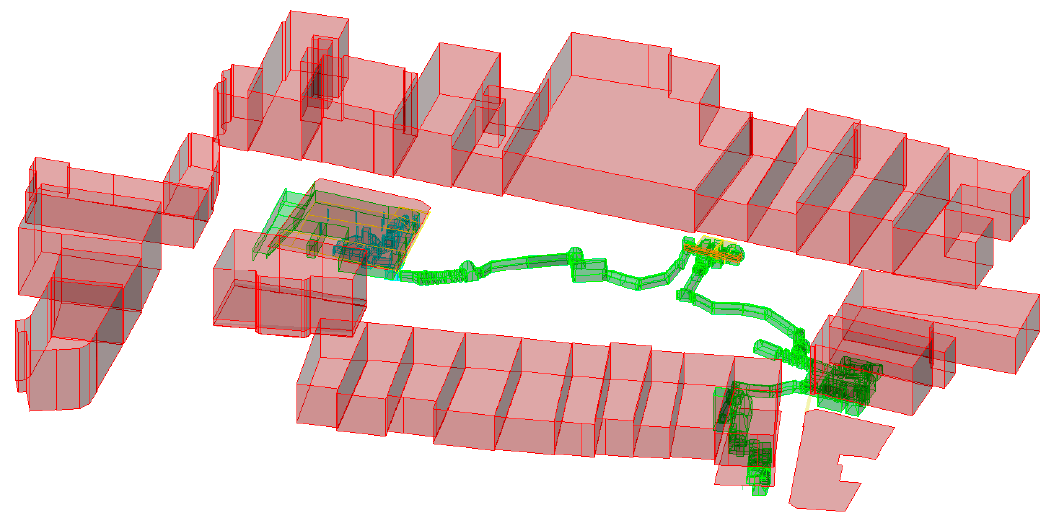
Figure 21. Three-dimensional model of the Underground Tourist Route with buildings.